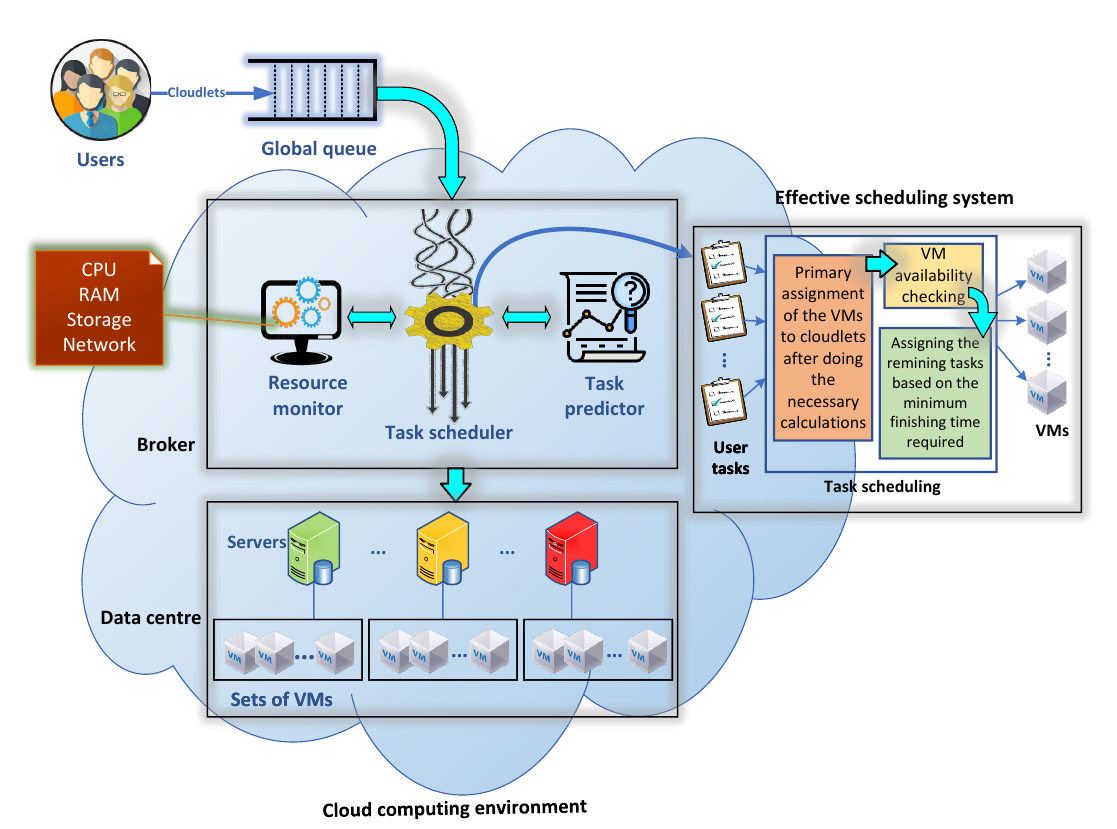
Figure 3. Proposed algorithm